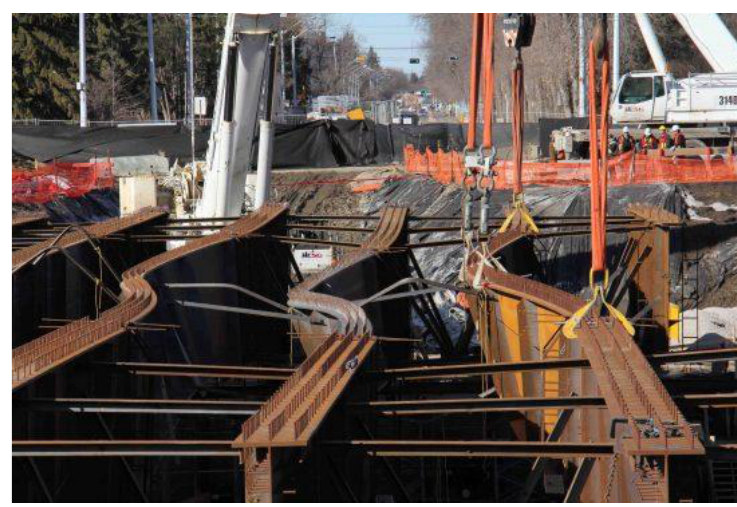
Figure 1. Lateral buckling of bridge plate girders in Edmonton, Alberta, Canada [4] .